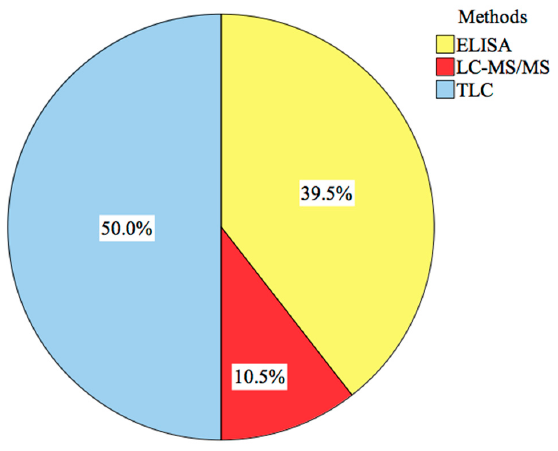
Figure 7. Usage of the most commonly analytic methods to detect aflatoxins in Mozambique. It counts every single measurement made by Casadei [6], Van Rensburg et al. [7], van Wyk et al. [1], Warth et al. [2] and Sineque et al. [8]. These studies were carried from 1985 to 2017 and included in total 934 samples including agricultural crops, chicken livers and gizzards.